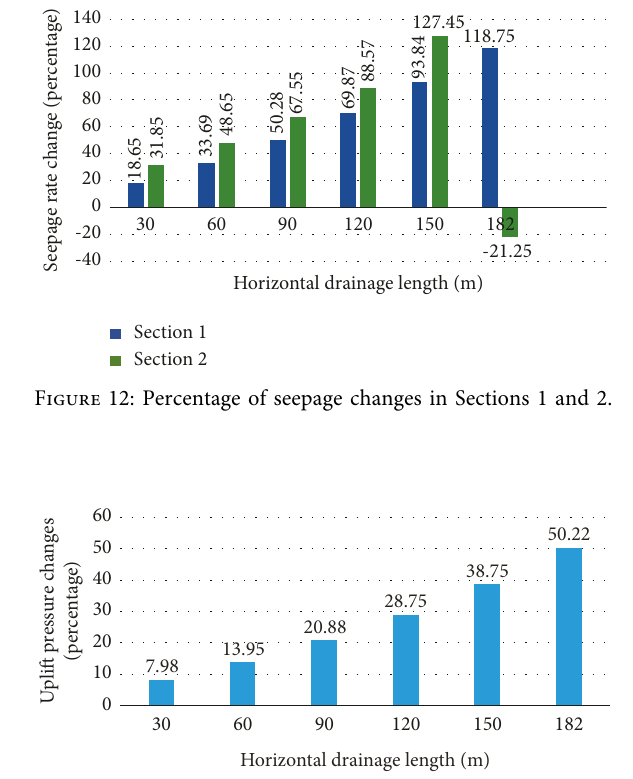
Figure 16: Percentage reduction of average uplift pressure in different positions of horizontal drainage.